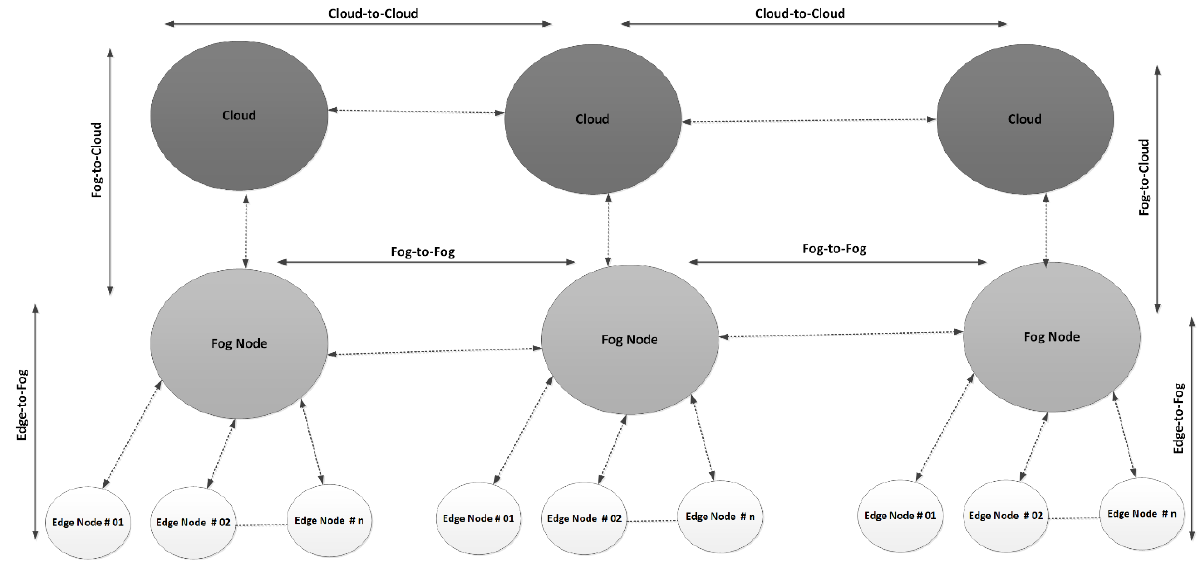
Figure 4. Node Configuration and